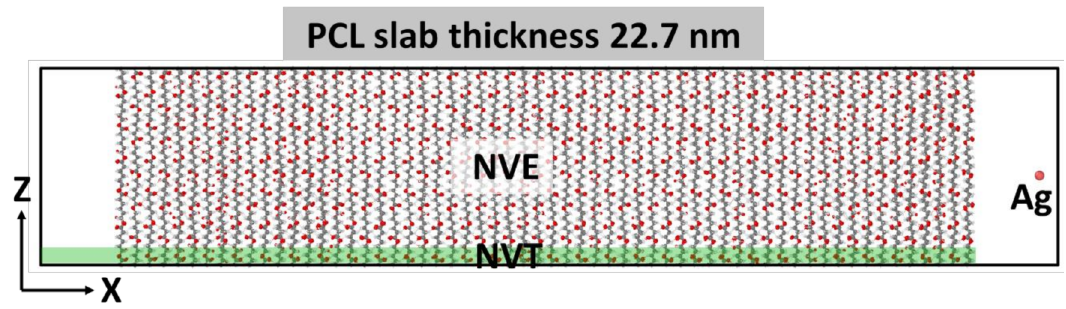
Figure 2. A diagram of the Ag ± implantation model with characteristic dimensions.